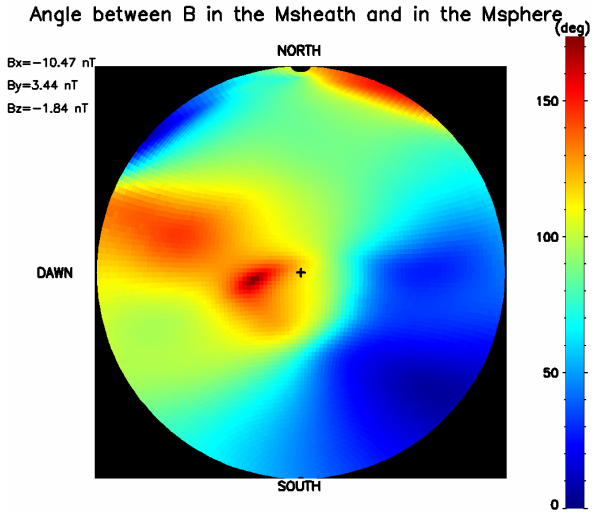
Fig. 13. Colour maps of the shear angle along the magnetopause during the far-off crossing of a fully north MC when its axis is lo- cated at x = 1000 R E upstream of Earth. See the caption of Fig. 9 for